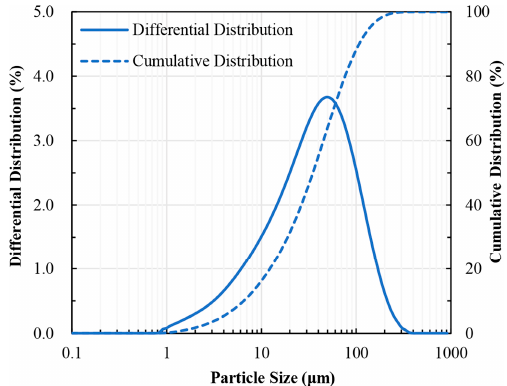
Figure 1. Particle size distribution in the CFA sample from the Qianxi power plant in Guizhou.